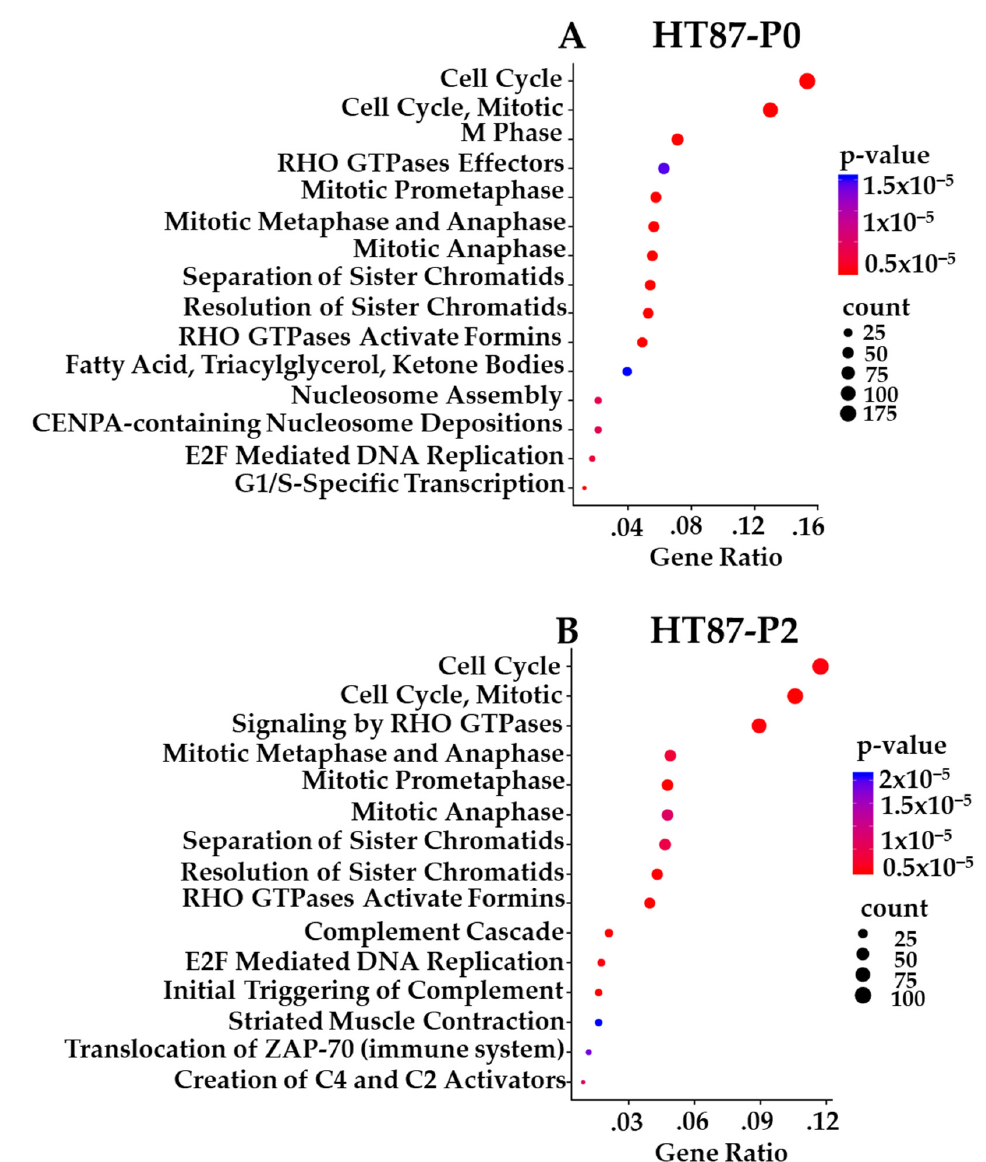
Figure 12. Pathway enrichment analyses of transcriptome for ( A ) HT87-P0 and ( B ) HT87-P2 illustrate cell cycle pathway as one of the most significant pathways of interest. Genes that were statistically significant ( p < 0.05) and >1.5-fold change were selected for pathway enrichment analysis using GO, KEGG, and Reactome.